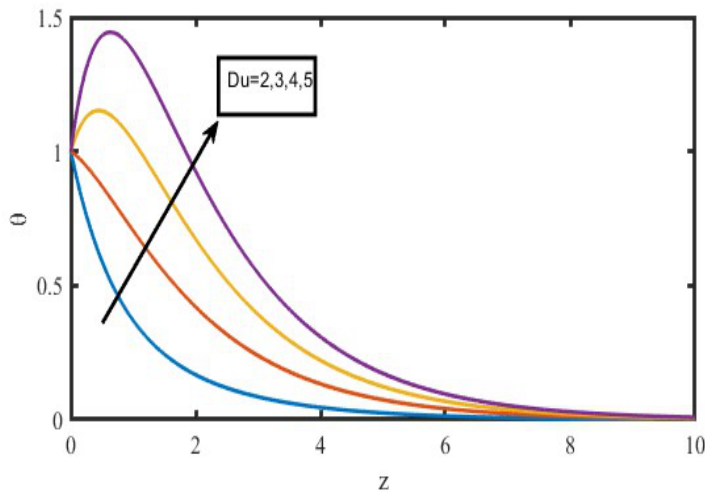
Figure 9. Temperature profiles for Diffusion thermo specification (D u ).